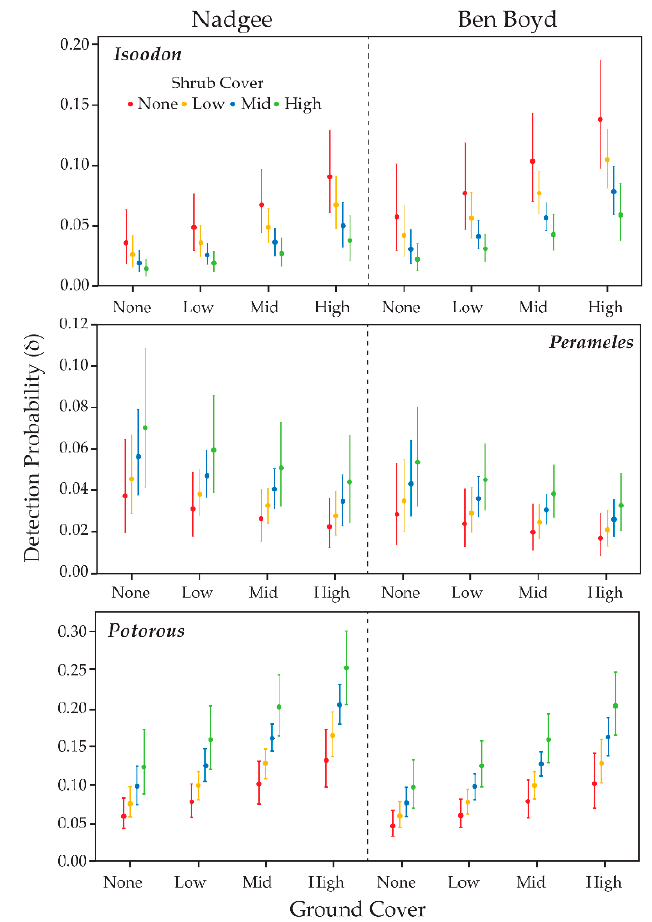
Figure 8. Estimated detection probability ( δ ) of Isoodon , Perameles and Potorous in Ben Boyd and Nadgee as a function of ground and shrub cover. As trends in each year were similar, only 2017 estimates are shown. Central dots represent the mean of the posterior distributions and bars represent 95% credible